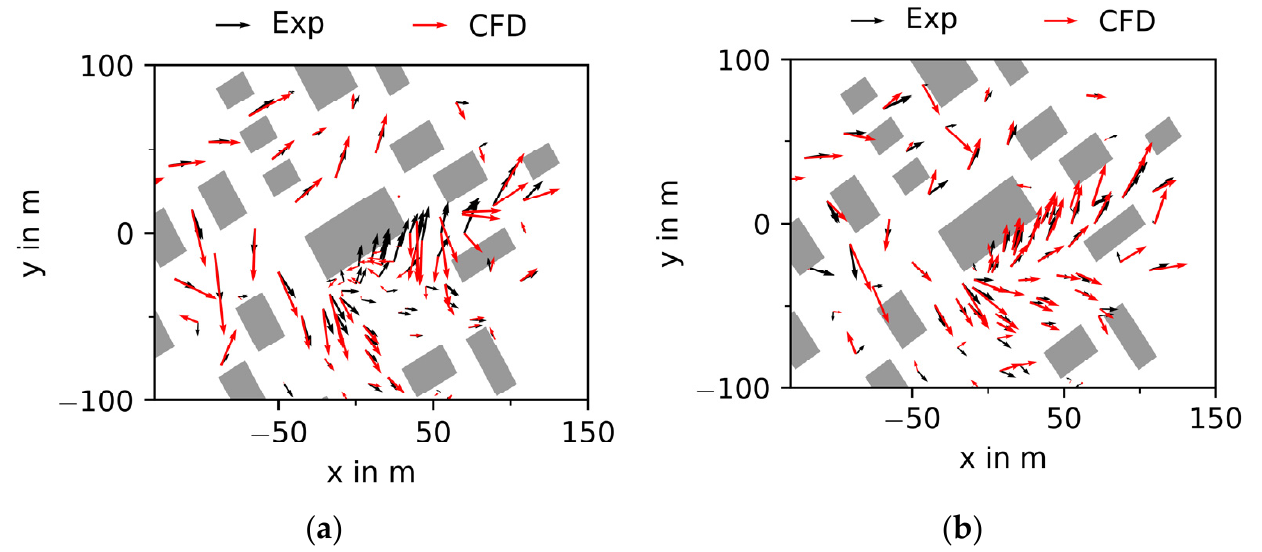
Figure 4. Comparison of the vectors of the horizontal wind components in a height of 2 m over the ground of the simulation (red arrows) with the experiments (black arrows); ( a ) incident flow at 30°; ( b ) incident flow at 35°.